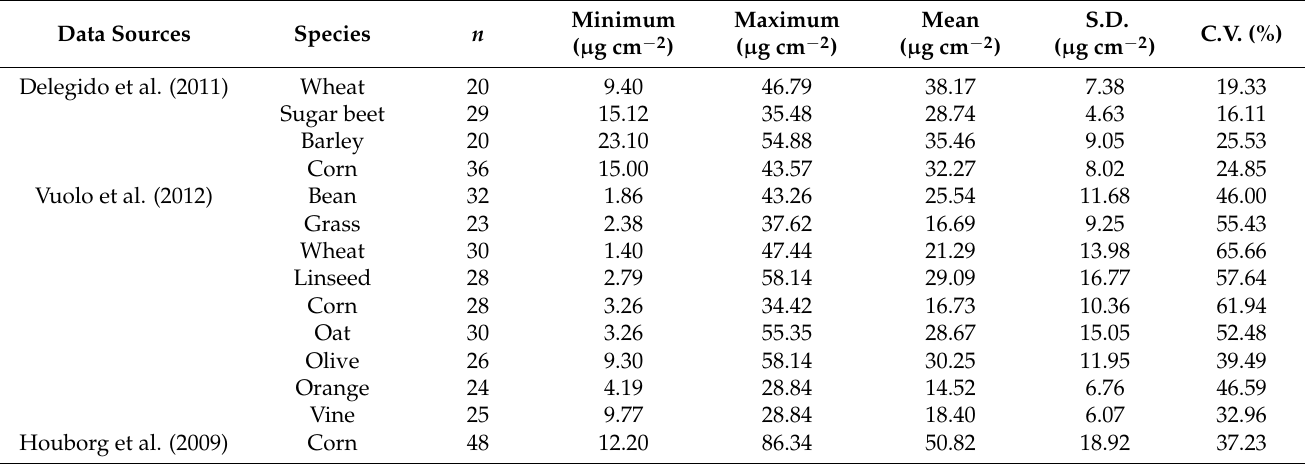
Table 1. Statistics of leaf chlorophyll content in Delegido’s, Vuolo’s, and Houborg’s datasets. S.D. is the standard deviation, C.V. is the coefficient of variation, and n represents the number of